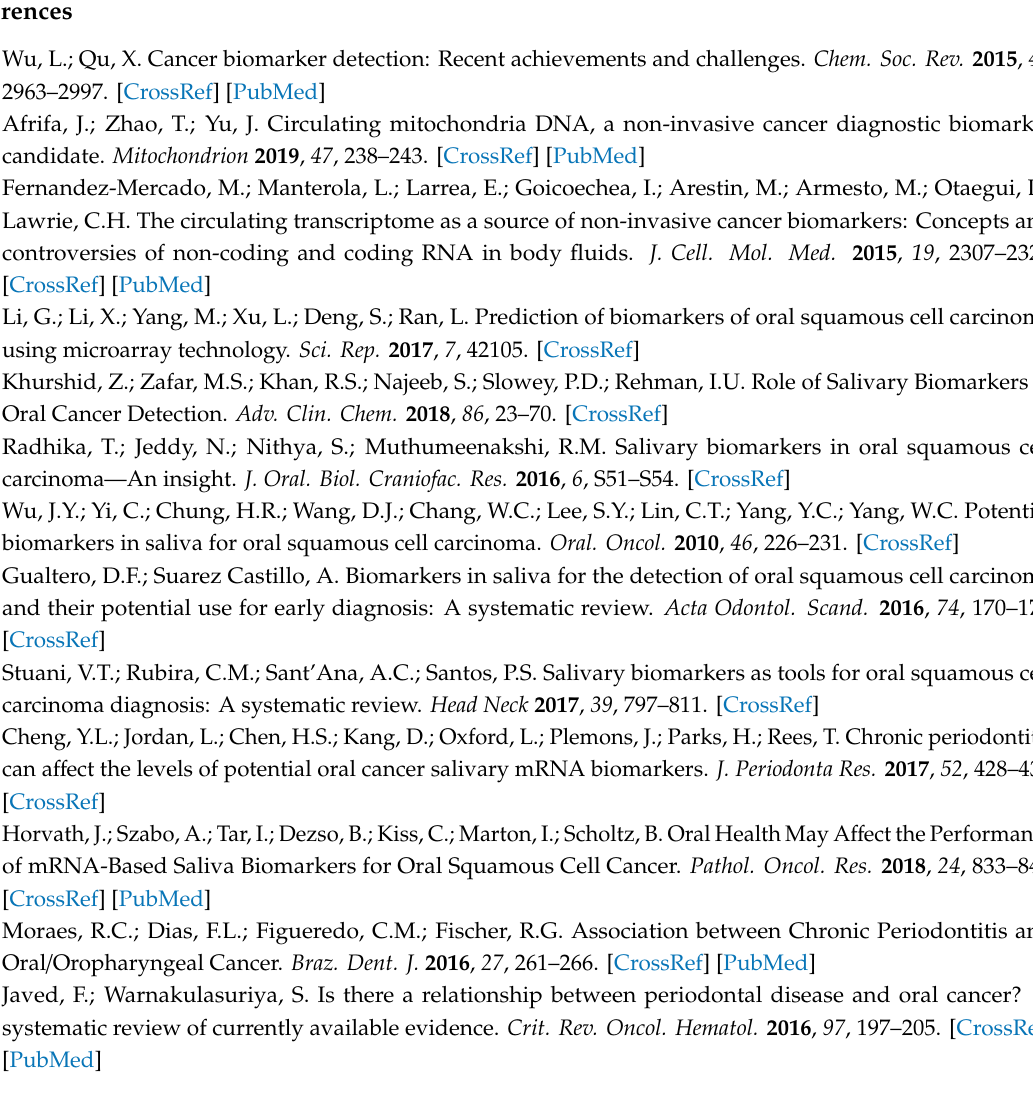
Table S1: Gene list considered for salivary biomarker, Table S2: Average mRNA level of 6 candidate genes in the under-60 age